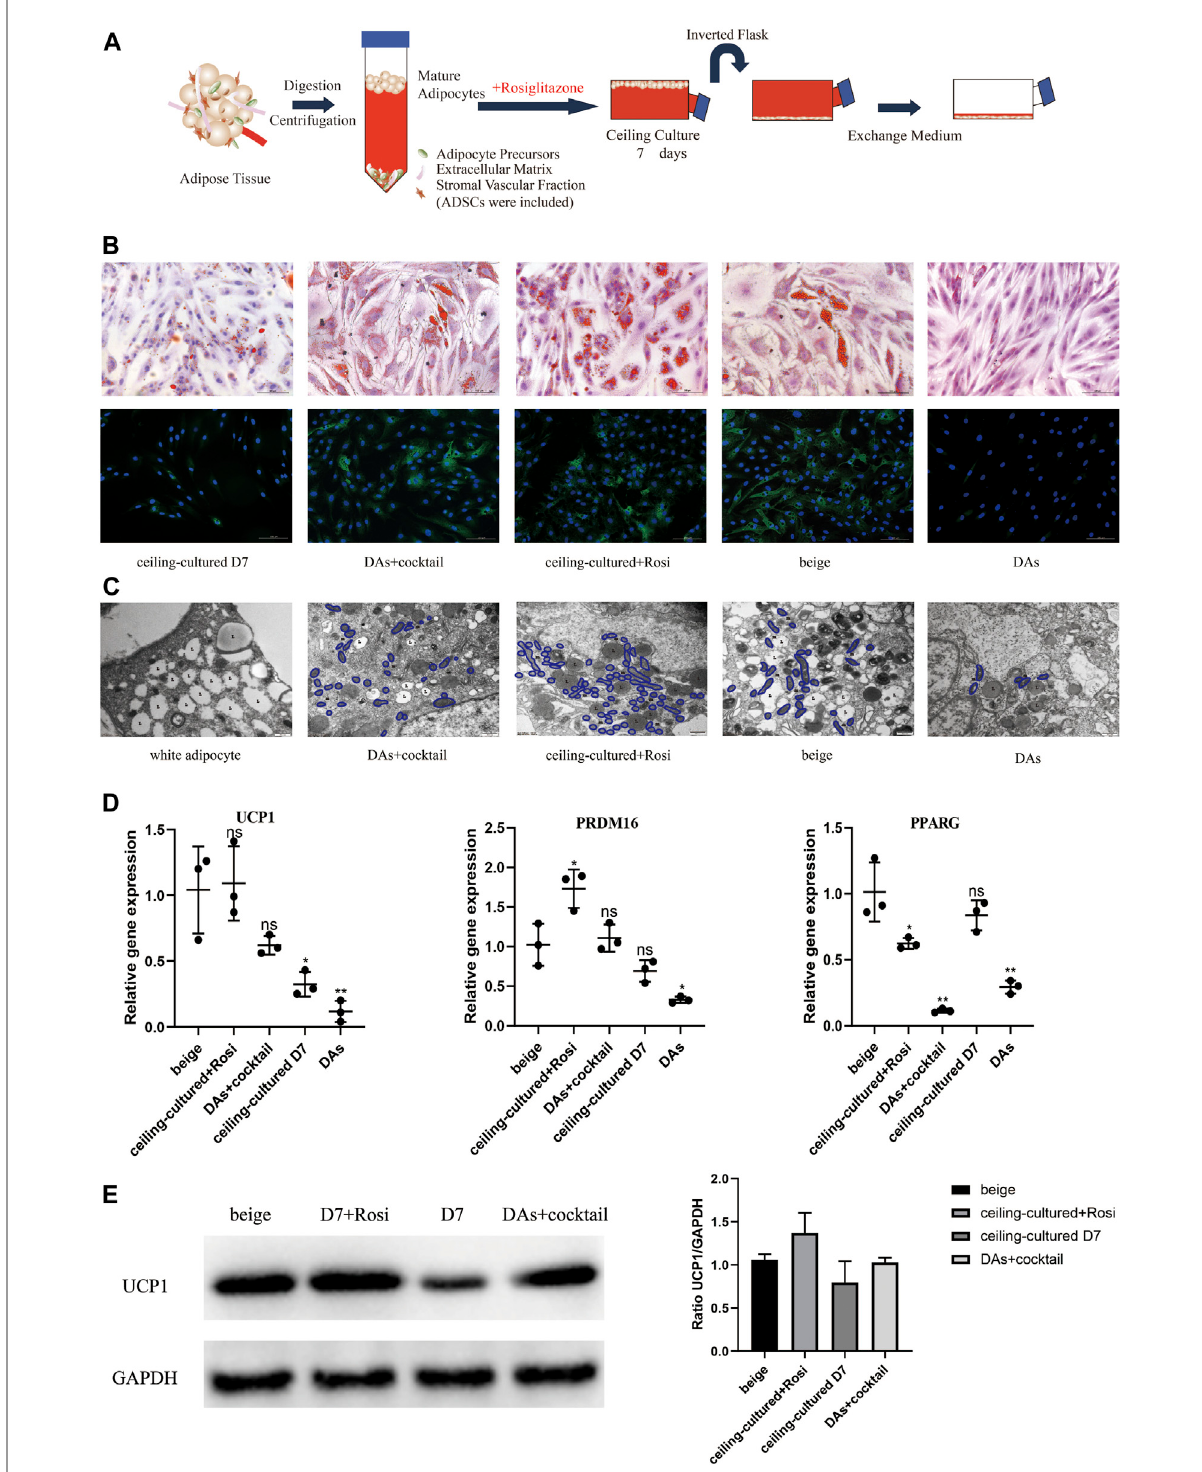
FIGURE 3 Ceiling-cultured adipocytes can transdifferentiate into beige adipocytes. (A) Model depicting the use of rosiglitazone to culture mature adipocytes. (B) Intracellular lipid droplets were stained with Oil Red O and visualized by light microscopy. Fluorescence microscopy visualized UCP1 expression stained with Alexa Fluor 488 (green) and nuclei stained with DAPI (blue). Scale bar 100 µm. (C) Transmission electron microscopy results showed that induced beige adipocytes and ceiling-cultured+Rosi cells exhibited condensed mitochondria compared with